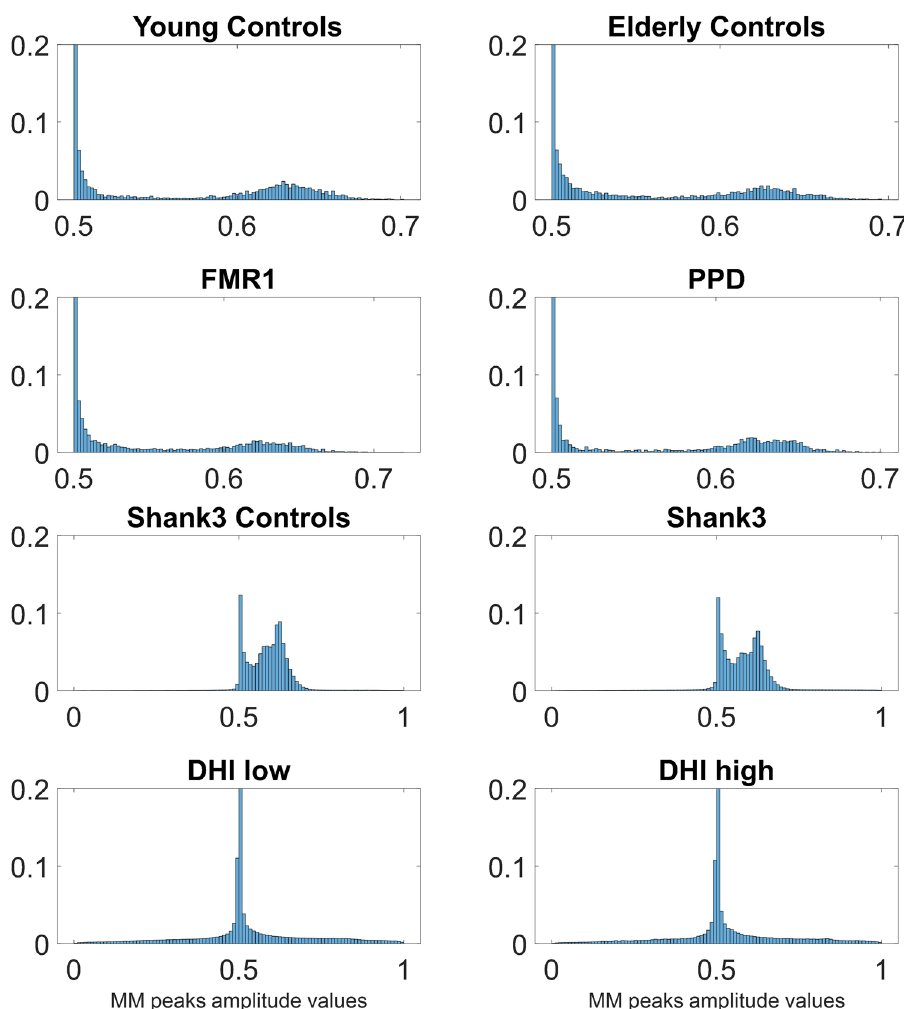
Figure 3. Unimodality vs. Multi-modality in the distributions of MMS from peak angular speed amplitudes differentiate the various groups. Different modes are specific to each cohort, mode 1 exponential and mode 2 Gaussian, with different dispersions and percentages of points in each mode. In contrast to other groups, both the low- and the high-score DHI groups, exhibit unimodal (highly kurtotic)